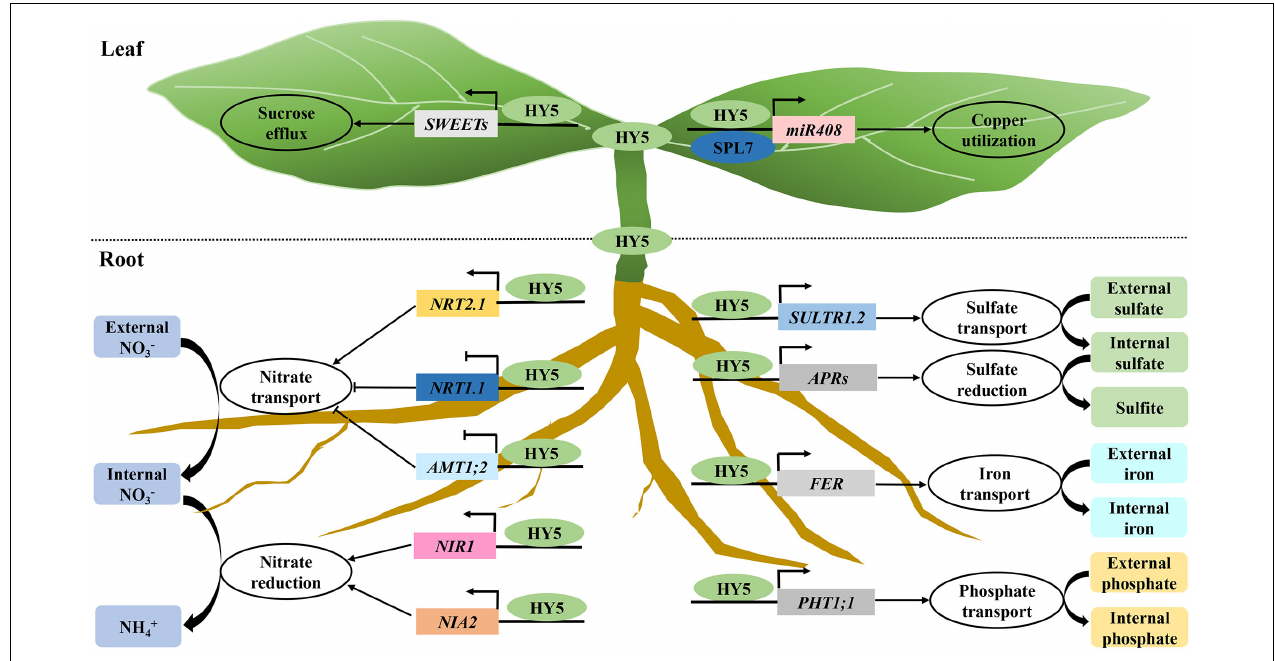
FIGURE 4 | HY5 acts as a central hub of nutrient signaling. Light triggers the accumulation of HY5 both in the shoot and root. HY5 activates the transcription of SWEETs and miR408 to promote sucrose and copper utilization. A portion of shoot localized HY5 proteins move to the root. HY5 proteins in the root regulate the transcription of genes involved in the uptake and/or transport of nitrogen, sulfur, Fe, and phosphate, thereby facilitating multiple nutrient assimilation.